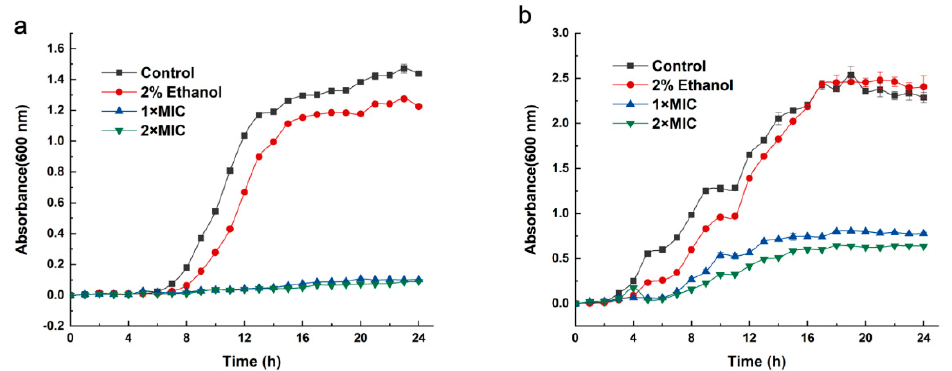
Figure1. Effectofdifferent3-careneconcentrationsonbacterialdynamicgrowthcurves. ( a ) B.thermosphacta , Figure 1. Effect of different 3-carene concentrations on bacterial dynamic growth curves. ( a ) B. ( b ) P. fluorescens thermosphacta , ( b ) P. fluorescens .